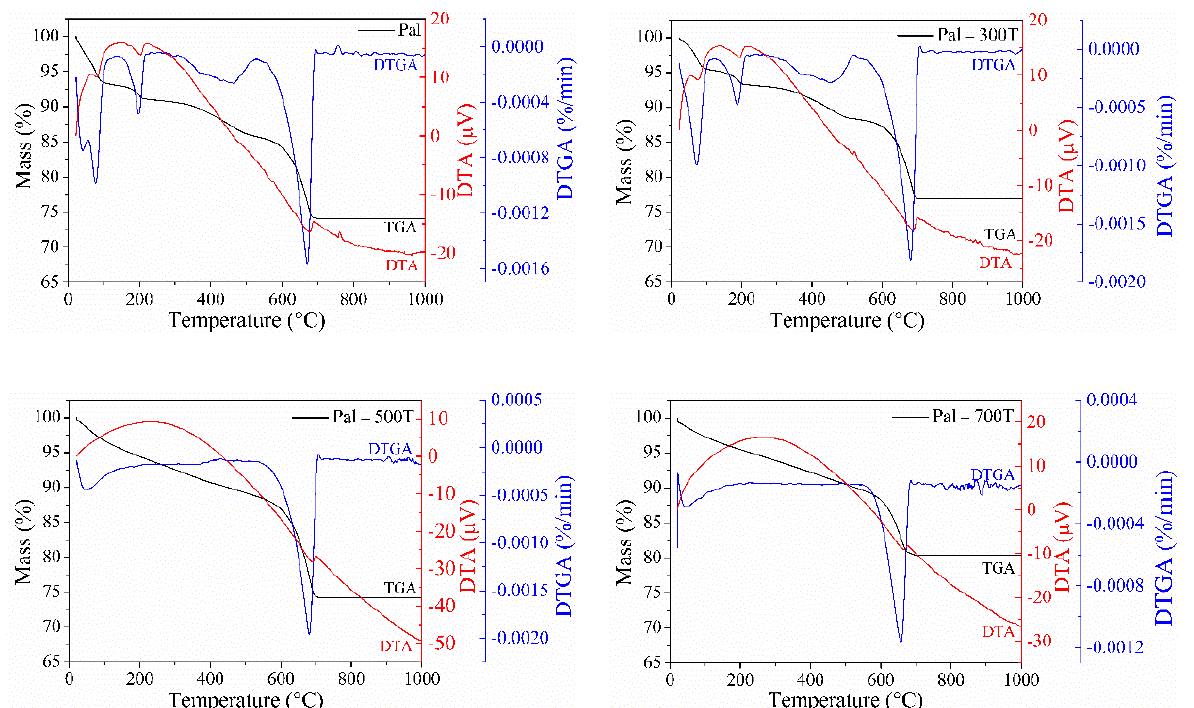
Figure 2. TGA-DTGA-DTA curves of palygorskite clay before and after heat treatment, obtained at a heating rate of 10 °C/min and under an air atmosphere.